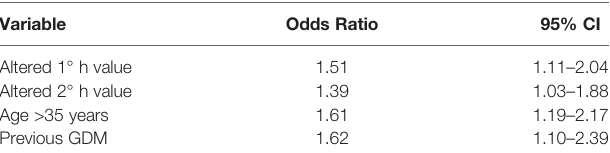
TABLE 7 | Variables signi fi cantly associated to the combined long-acting and rapid analogues insulin treatment for GDM from multivariate stepwise logistic